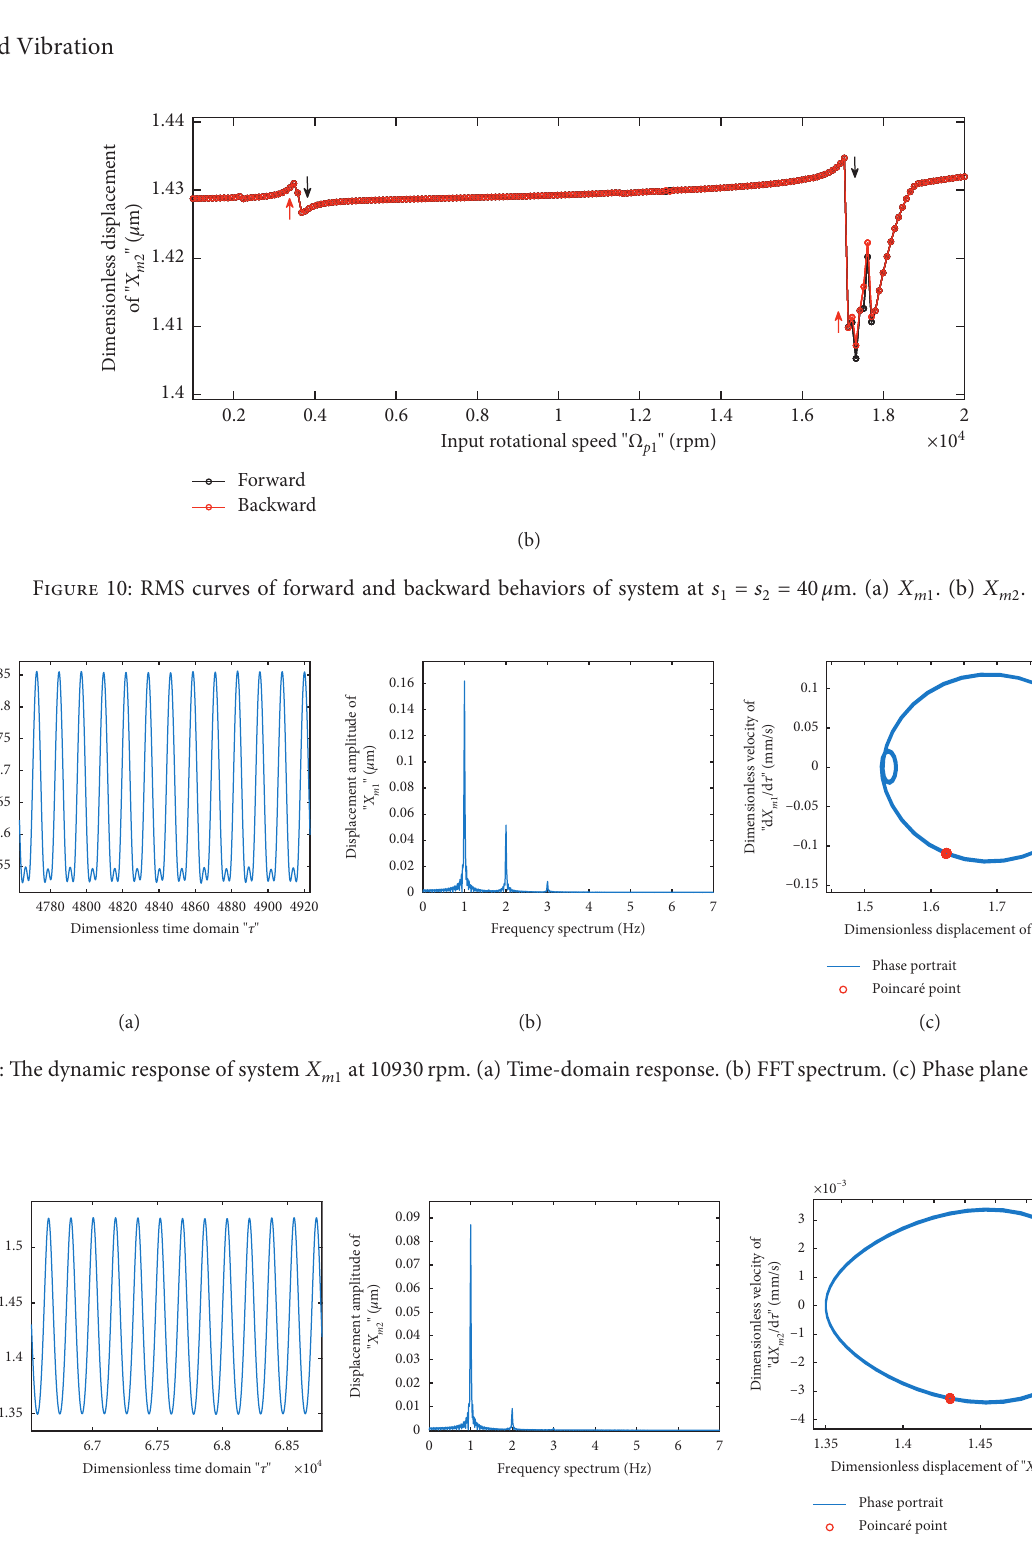
m 2 at 1500rpm. (a) Time-domain response. (b) FFTspectrum. (c) Phase plane and Poincar´e